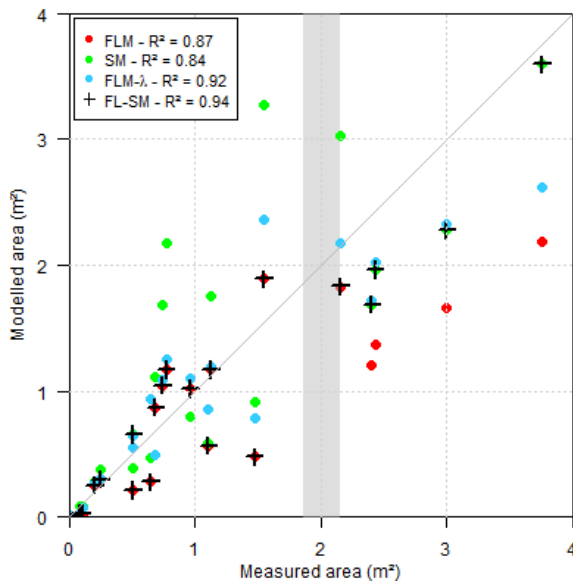
Figure 7. Performance of the coupled model (FL-SM), the Fos- ter and Lane (1983) model (FLM and FLM- λ ) and the Sidorchuk (1999) model (SM). p value < 0 . 001 for all sets. The grey bar indi- cates the identified threshold area where there is a change and the SM becomes consistently better than the